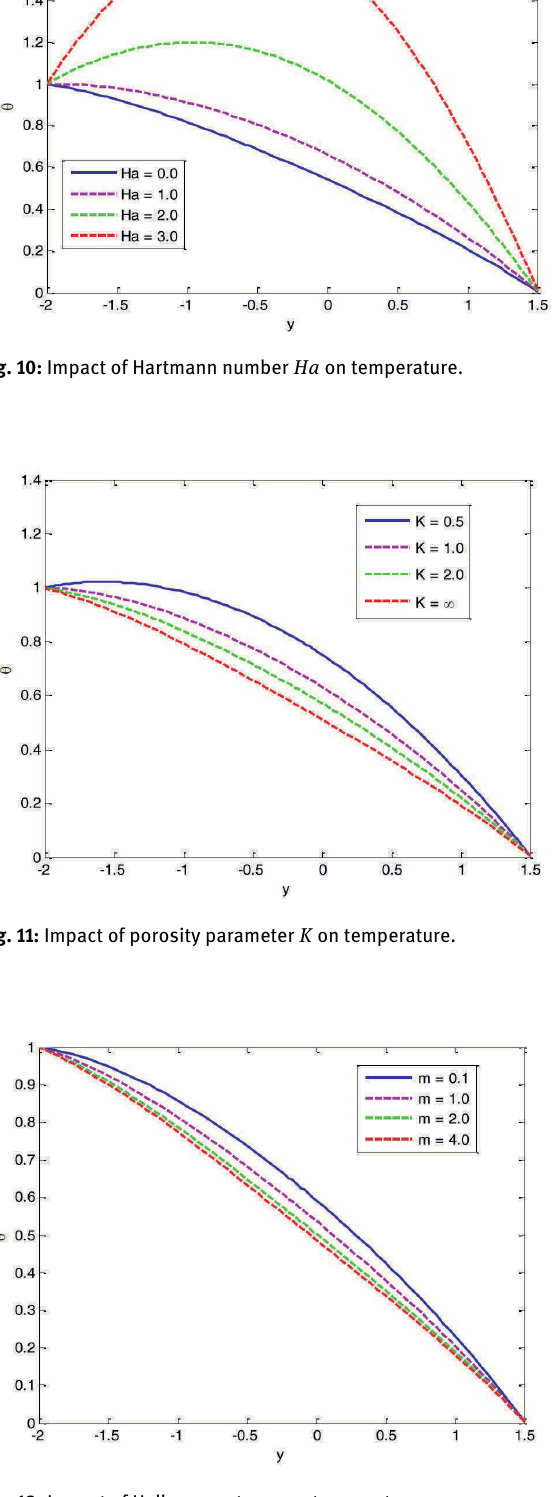
Fig. 15: Impact of Brinkman number Br on